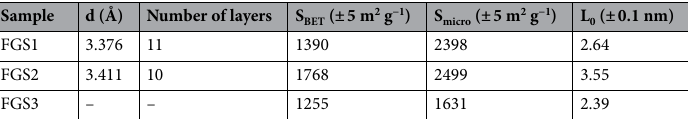
Table 1. Physicochemical characterization of GO/SiO 2 nanocomposites.